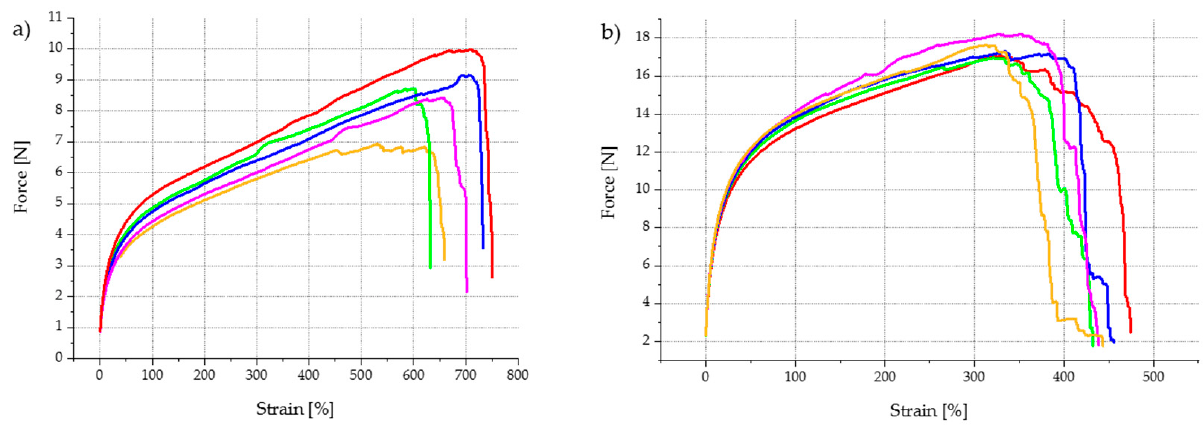
Figure 5. Stress–strain diagram of TPU multifilament yarns, melt spun at 15 m/min: ( a ) 97 wt.% TPU + 3 wt.% CNT; ( b ) 94 wt.% TPU + 6 wt.% CNT.